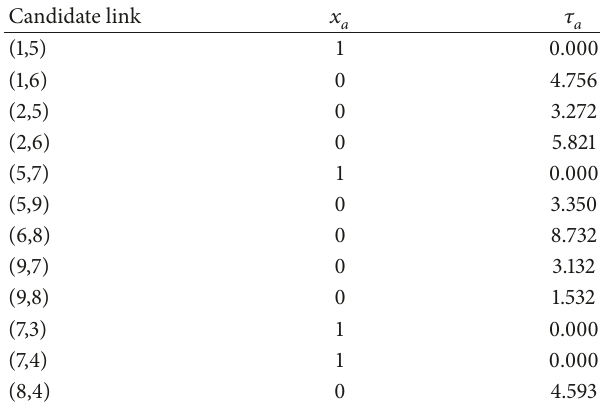
Figure 3: Lower and upper bounds at each iteration of the relaxation-based method. Table 1: Optimal network design with congestion